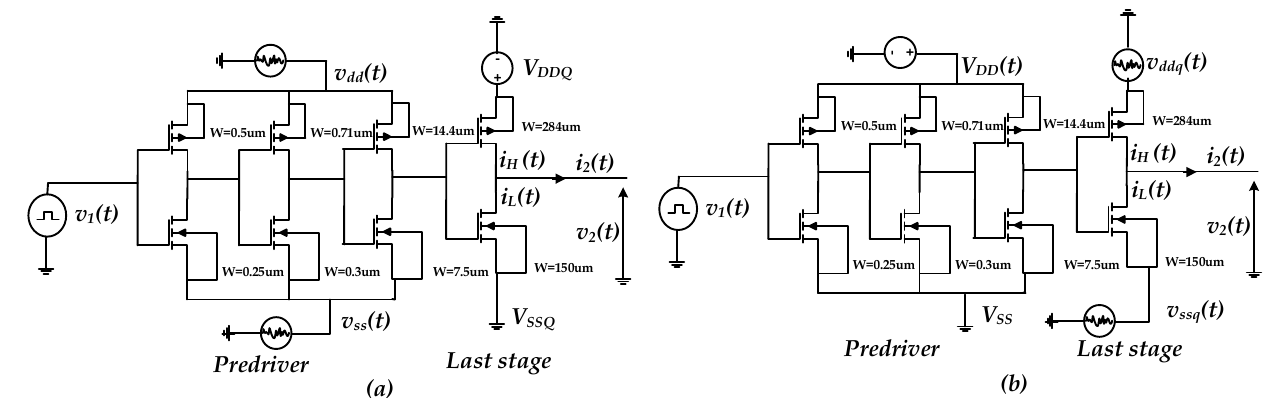
Figure 4. Simulation setup used to evaluate the impact of PGSV variations independently connected at the ( a ) pre-driver or ( b ) driver’s last stage.